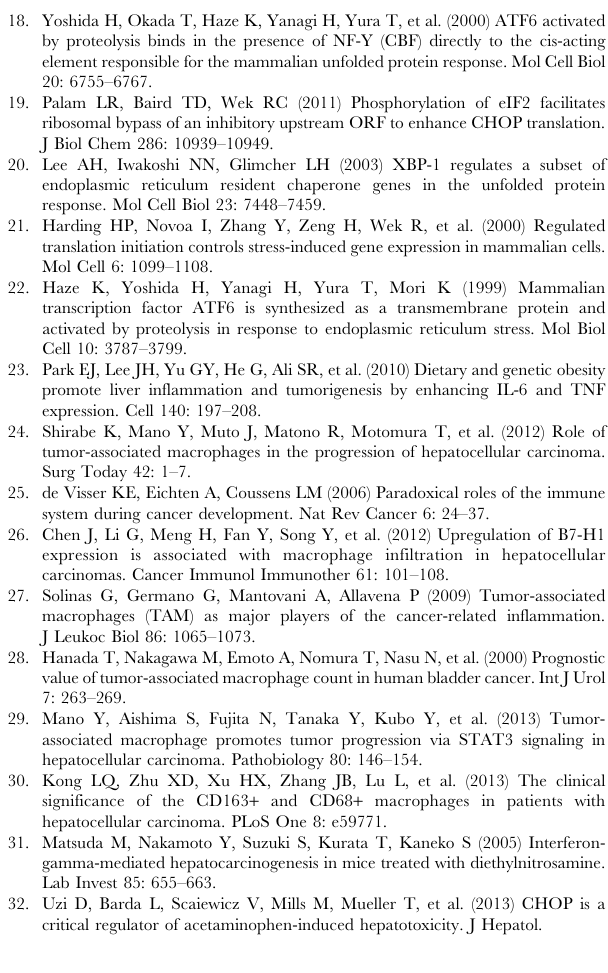
File S1 Table S1. List of antibodies. Table S2. Primers list for qPCR. Figure S1. ATF6 is activated in human HCC. Figure S2. CHOP and ATF6 are activated in different human